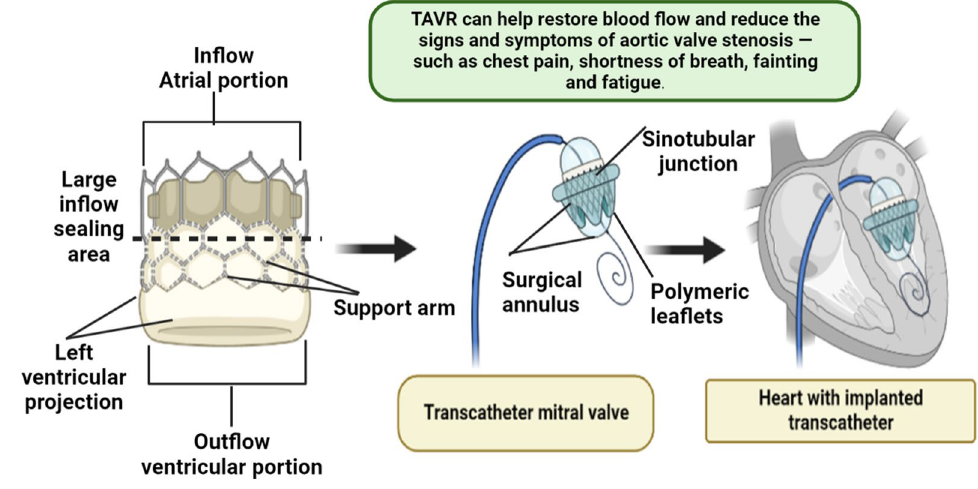
Fig. 8 Heart with Implanted